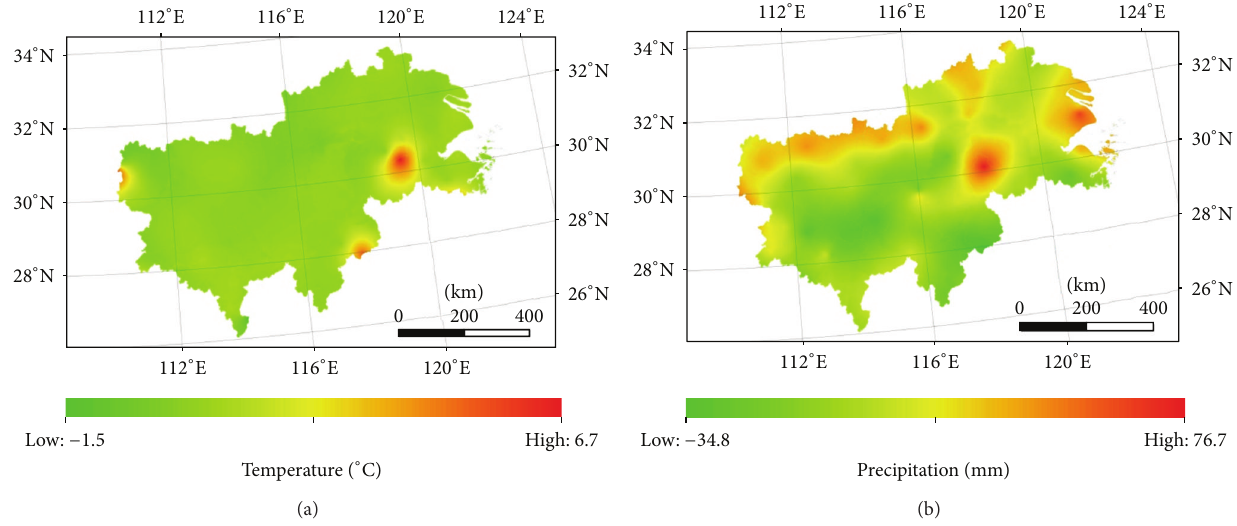
Figure 7: Changes in spatial distribution of annual average temperature (a) and precipitation (b) in the middle and lower reaches of the Yangtze River,